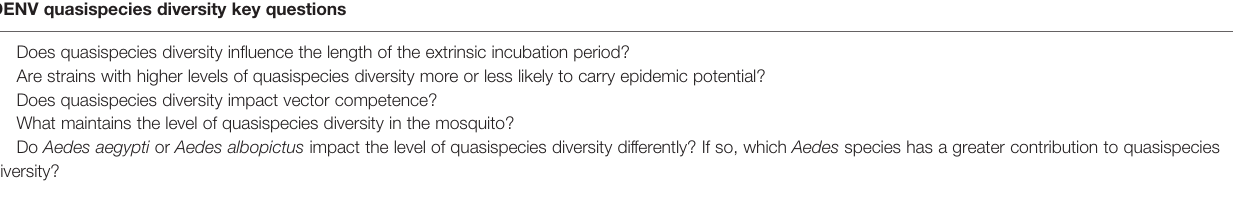
DENV quasispecies diversity key